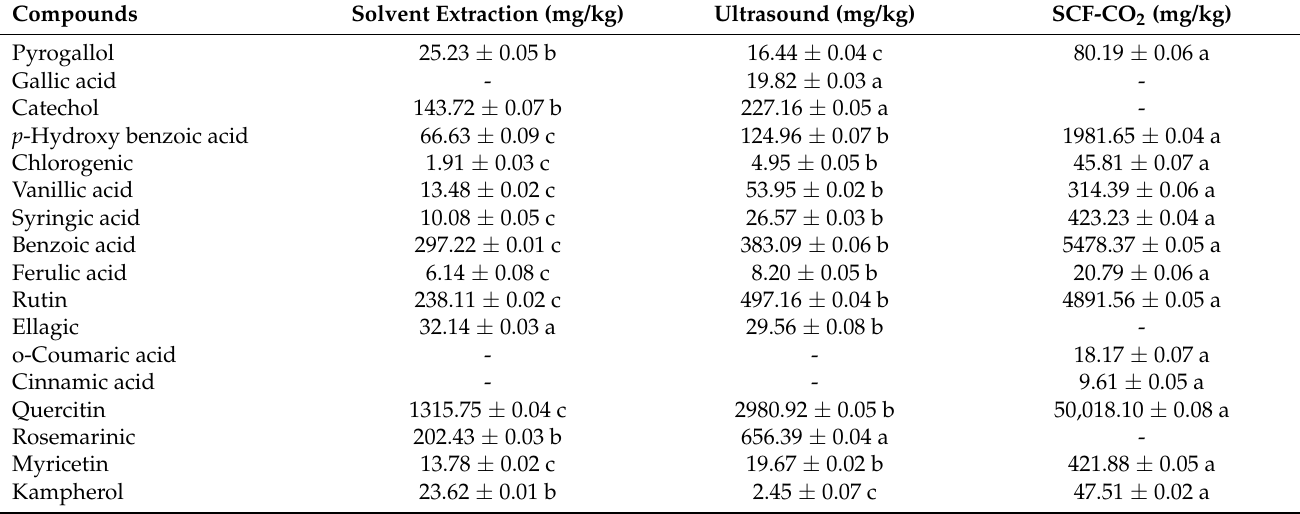
Table 4. Total phenolic compounds and identification of phenolic